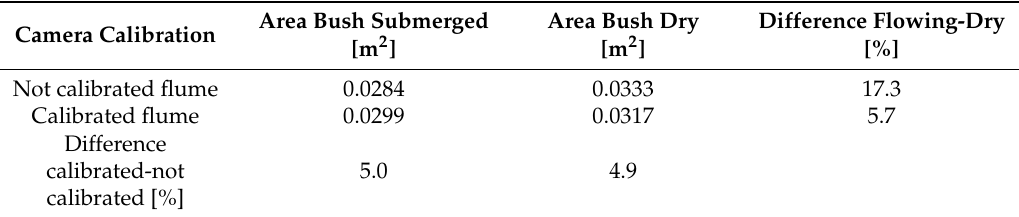
Table 4. Bush area using the endoscope camera in the